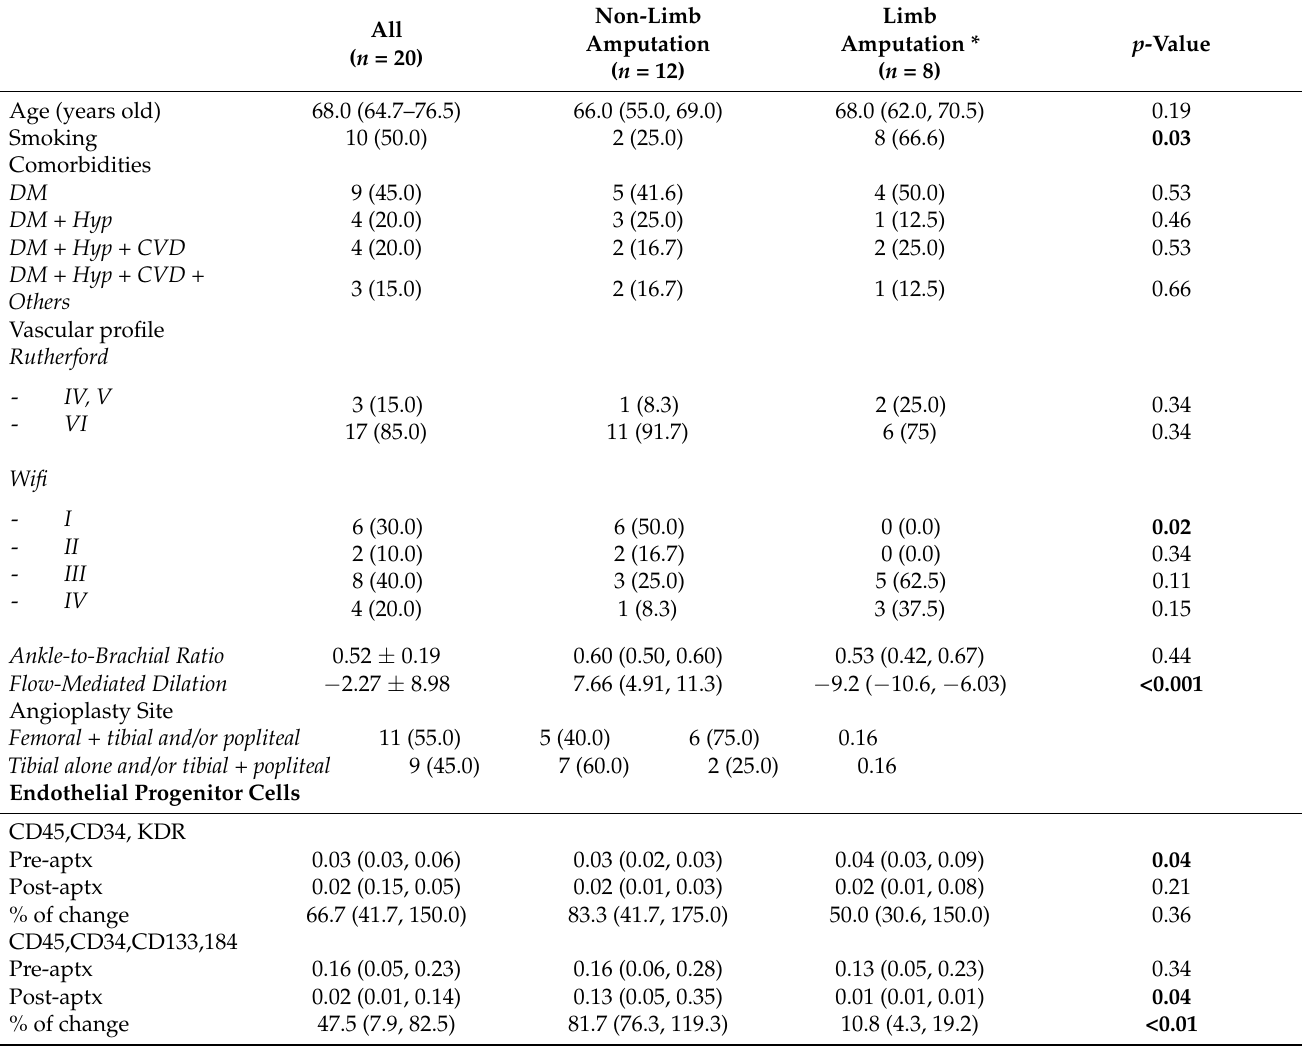
Table 2. Study population ( n =